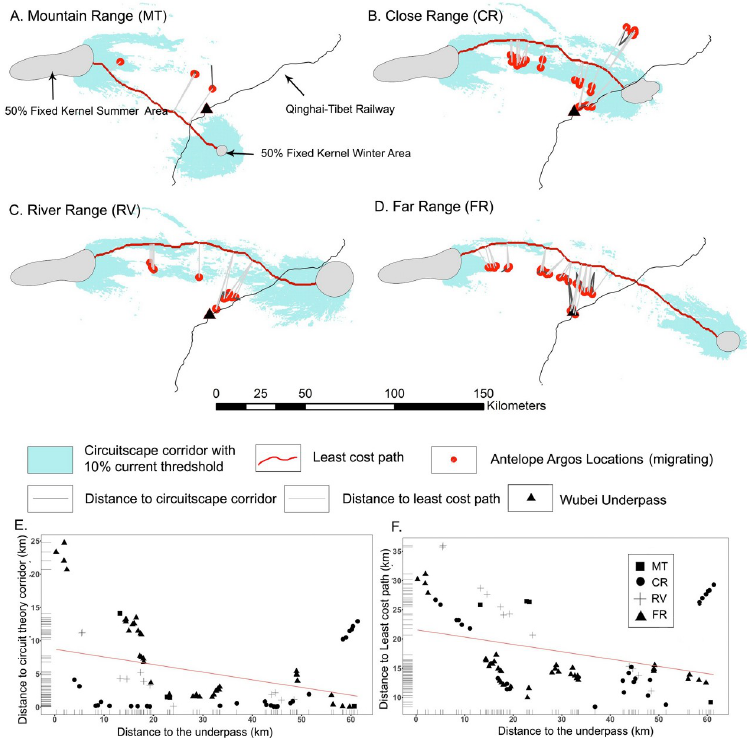
Fig 3. Modelled migration corridor and Argos locations of Tibetan antelopes. (A)-(D) Distance between Argos locations to modeled migration routes based on circuit theory and least-cost path, respectively, for each wintering site. (E) Distance to the underpass vs. Distance to circuit theory corridor. (F) Distance to the underpass vs. Distance to least-cost